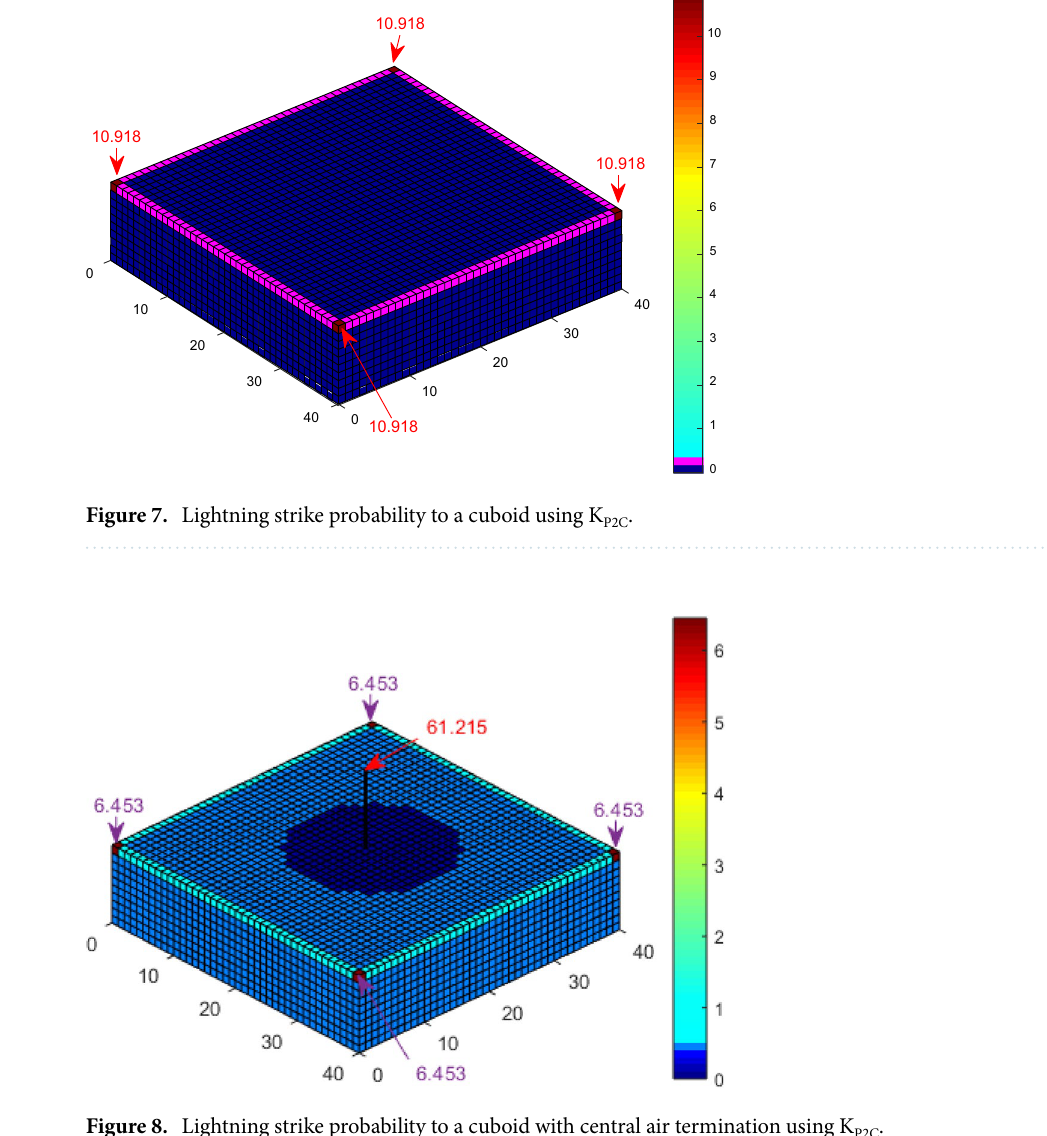
Figure 8. Lightning strike probability to a cuboid with central air termination using K P2C